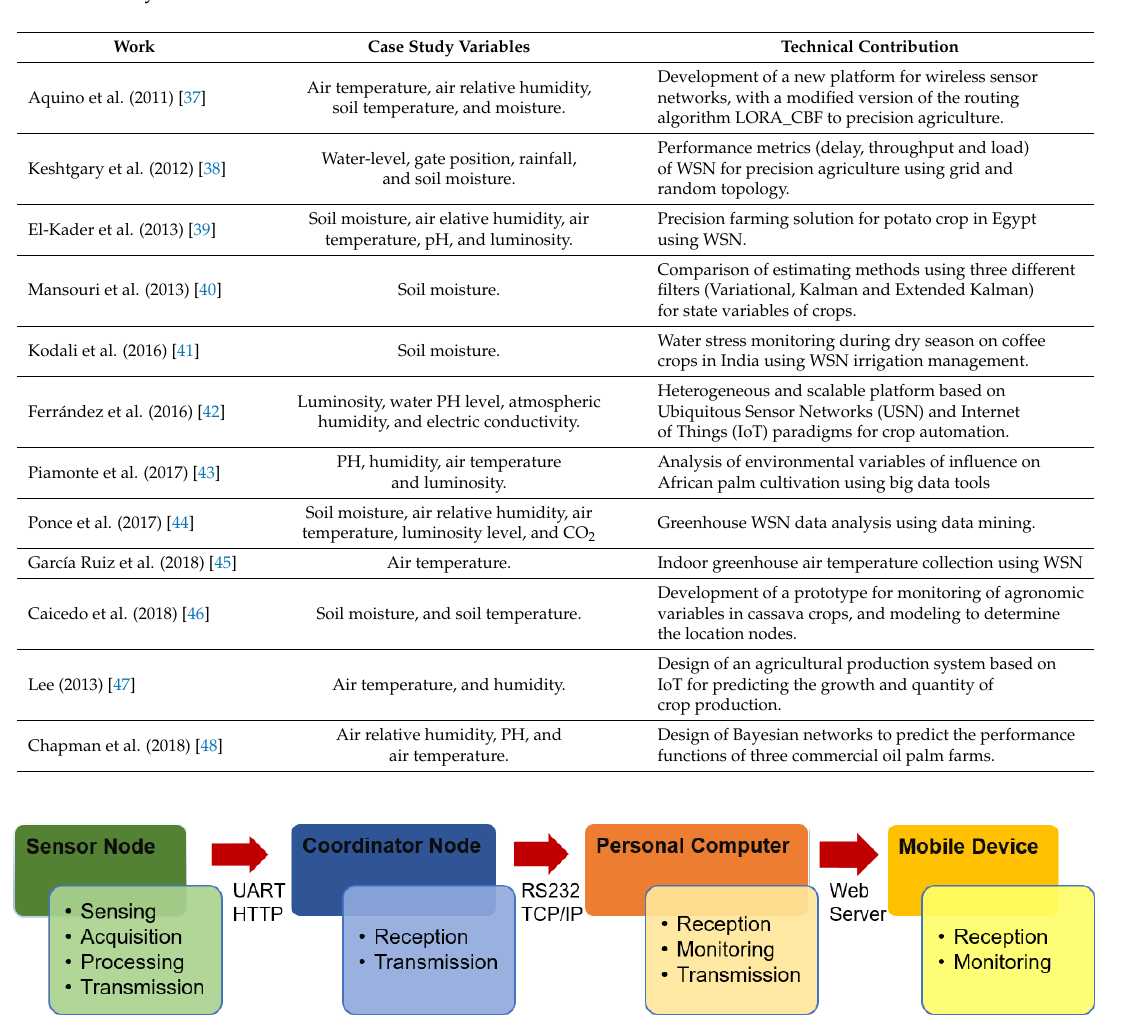
Table 1. State of the art of relevant works in the WSN literature related to environmental variable data analysis.